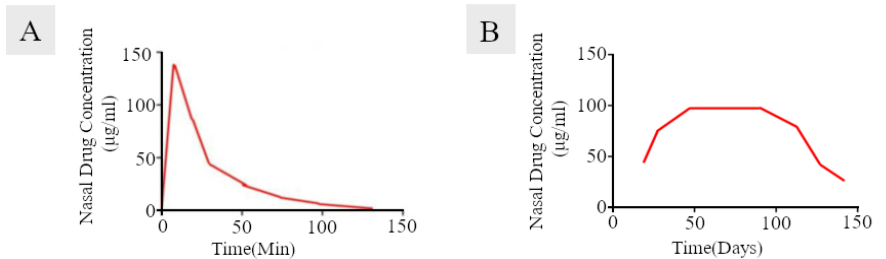
Figure 6. Nasal drug concentration versus time, obtained after administration of nasal sprays and drug-eluting implants. Nasal sprays show rapid clearance of the drug from the nasal mucosa (panel ( A )) as compared to locally acting implants (panel ( B )). Adapted from an open-access source: [15] .